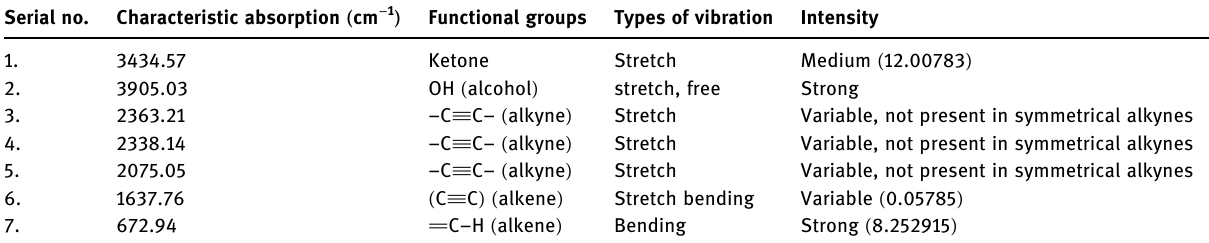
Table 2: FTIR of methanolic extract of D. viscosa Serial no.